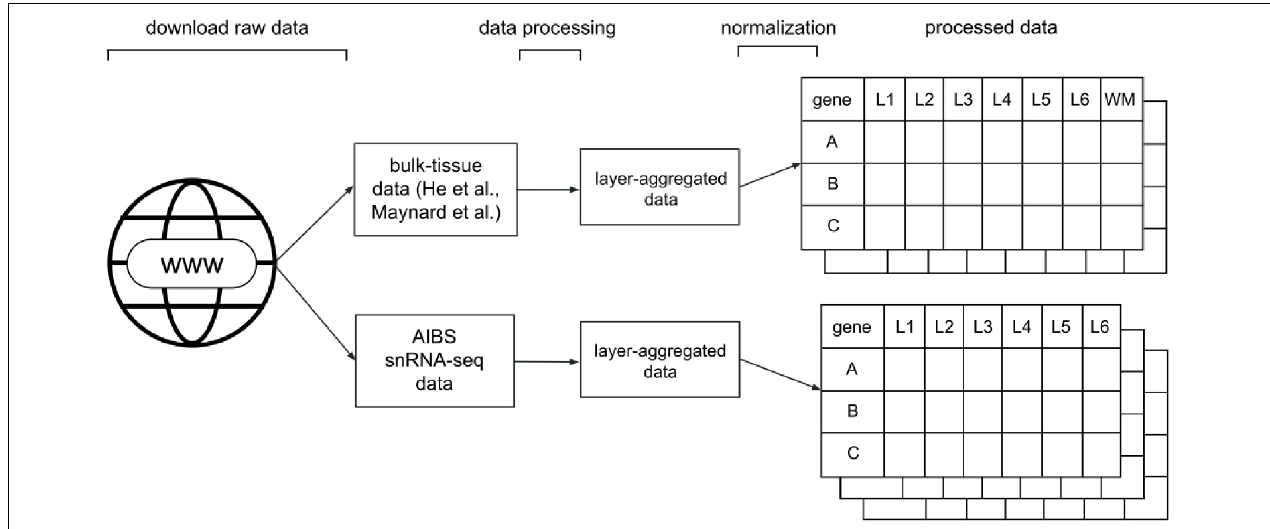
FIGURE 1 | Diagram of the data processing pipeline. For the He and Maynard data, the standardization and processing stages result in an expression matrix of genes (rows) by layers, from layer 1 (L1) to 6 (L6) or white matter (WM). For the snRNA-seq data, the pipeline results in three gene expression matrices for each major cell-type label provided by the AIBS (GABA: GABAergic, GLUT: glutamatergic, NONN: non-neuronal).